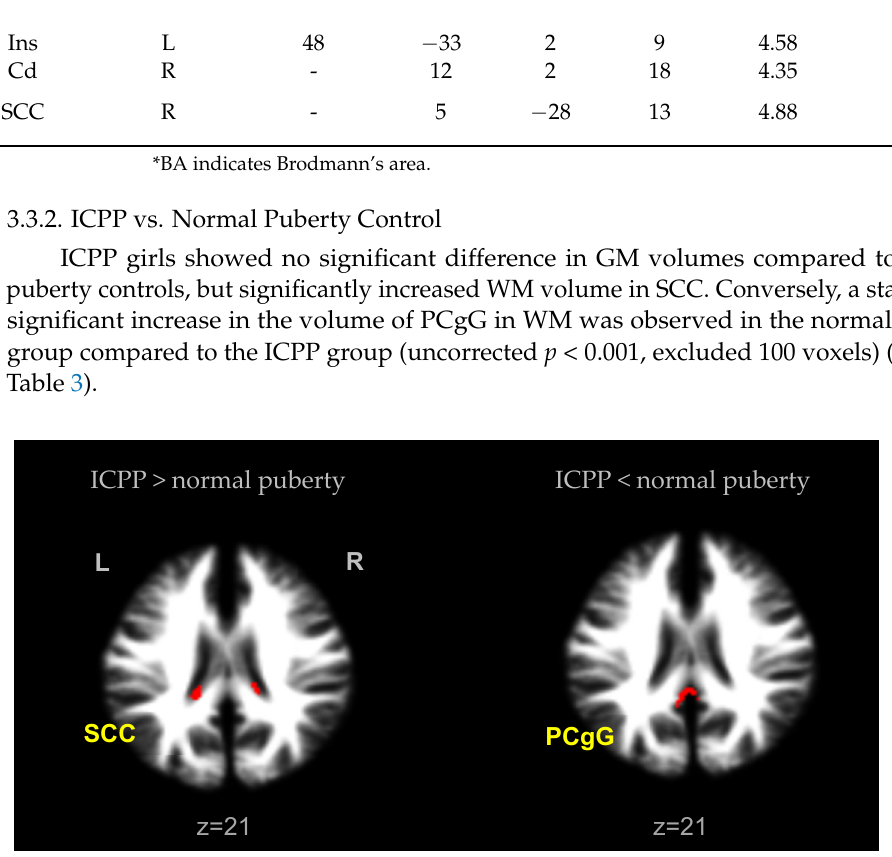
Figure 2. Brain areas with a significant difference in WM volumes in ICPP girls in contrast to normal puberty girls (uncorrected; p < 0.001, excluded 100 voxels). SCC, splenium of corpus callosum; PCgG, posterior cingulate gyrus. Table 3. Brain regions showing different white matter volumes between patients with ICPP and normal puberty controls (uncorrected; p < 0.001, excluded 100 voxels).